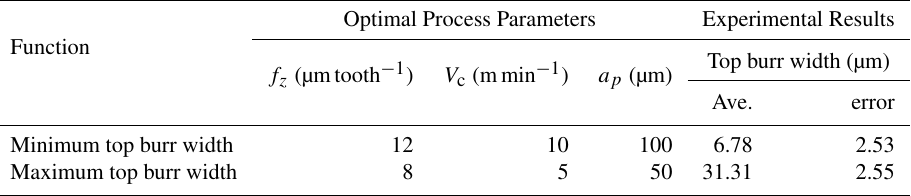
Table 8. Experimental results at optimum